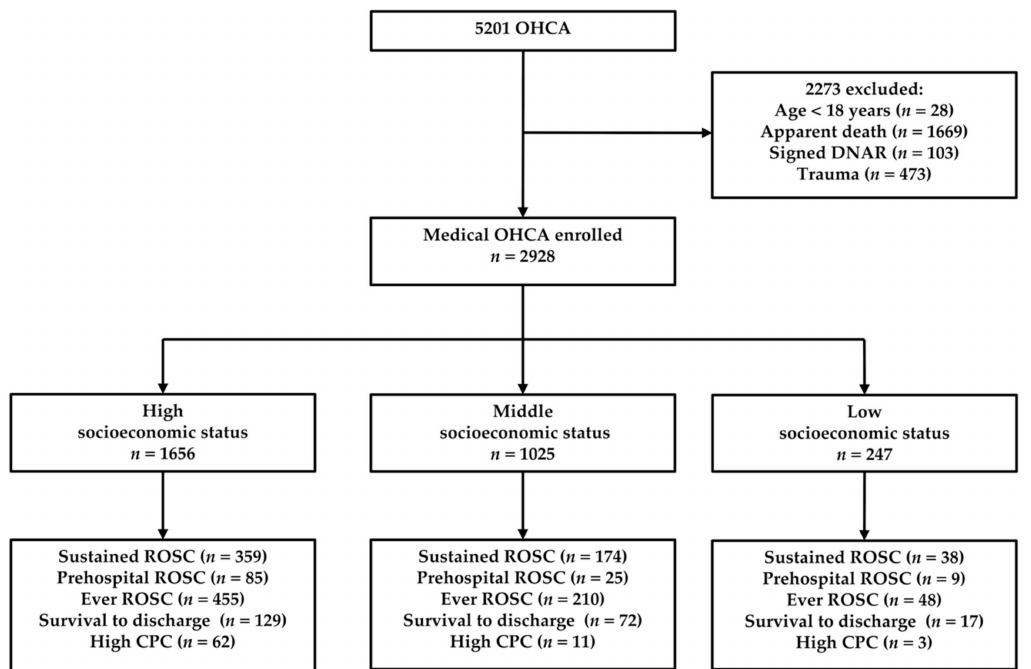
Figure 1. Overview of patients with OHCA during the study period. Abbreviations: CPC: cerebral performance category; DA-CPR: dispatcher-assisted cardiopulmonary resuscitation; DNAR: do-not-attempt-resuscitate; OHCA: out-of-hospital cardiac